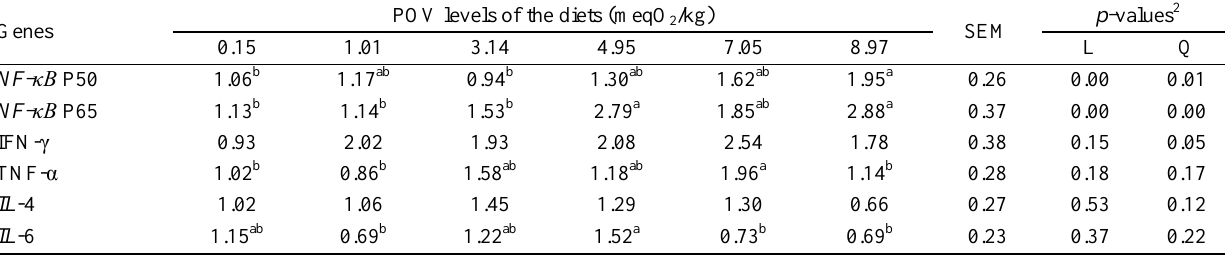
POV levels of the diets (meqO 2 /kg)